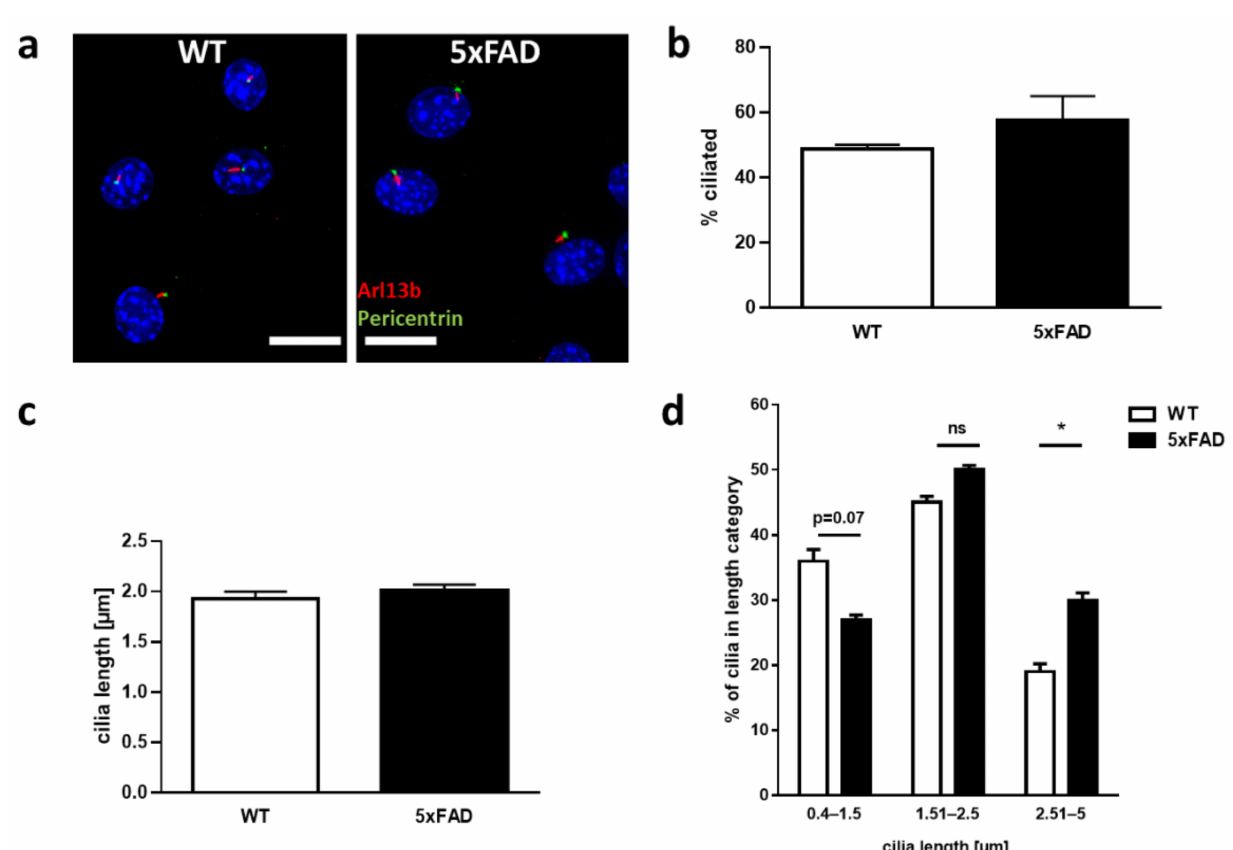
Figure 3. Higher prevalence of elongated primary cilia in 5xFAD-derived enteric neurons. ( a ) Staining of cilia. Neurons were prepared as described before and seeded on cover slips. A representative microscopic image of neurons after staining for the ciliary membrane protein Arl13b (red) and the basal body marker Pericentrin (green) and counterstain with DAPI (blue) of both genotypes is shown (scale bars: 10 µ m). ( b ) Quantification of ciliated cells. Number of cells carrying cilia was assessed and is presented in% of value obtained for wild type controls. The percentage of ciliated cells was calculated by determination of DAPI stained cells that showed Arl13b- and Pericentrin-double labelled primary cilia. Cultures derived from 4 independent donor mice in each group were analyzed with technical triplicates from 20 random visual fields with an average of 8 cells per image. ( c , d ) Cilia length was measured with ImageJ and mean length ( c ) or distribution in regard to length groups ( d ) was shown. Cultures derived from 3 (WT) and 4 (5xFAD) independent donors were analyzed with technical duplicates ( n = 159 cilia measured for WT and 260 for 5xFAD). Data are presented as mean + SEM.